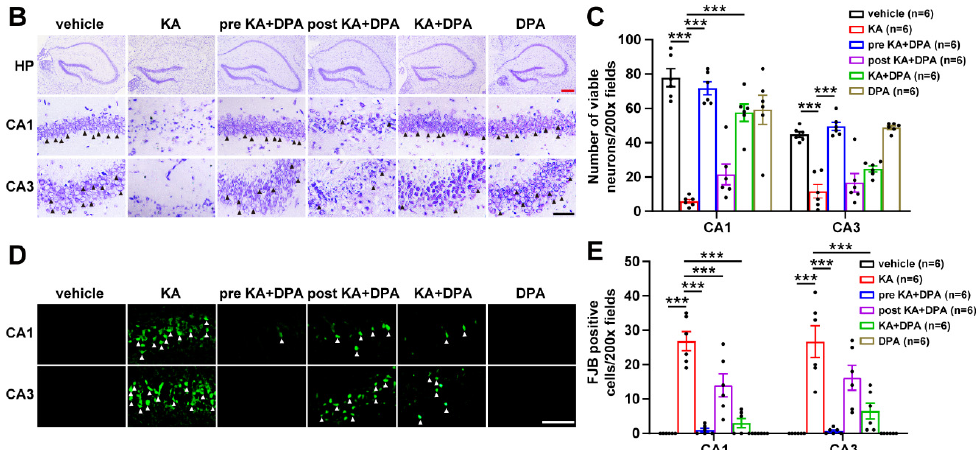
Figure 1. DPA ameliorates seizure-induced neuronal injury in KA-treated mouse model. ( A ) Exper- imental regimen for DPA (0.5 mg/kg) treatment. KA (250 ng/ μ L) was stereotactically injected to induce repetitive seizures (status epilepticus, marked with SE in this figure). Histological analysis including Nissl staining and FJB detection was carried out 3 d after KA or PBS injection. ( B ) Repre- sentative images by Nissl staining in the hippocampus showing the effects of DPA on viable neu- rons in KA-treated mice. Arrows indicate Nissl positive cells. Red scale bar indicates 200 μ m; black scale bar indicates 50 μ m. ( C ) Statistical analysis of Nissl staining results in hippocampal CA1 and CA3 subregions. ( D ) Representative images by FJB staining in the hippocampus showing the effects of DPA on the neurodegeneration in KA-treated mice. Arrows indicate FJB positive cells. Scale bar indicates 25 μ m. ( E ) Statistical analysis of FJB staining results in hippocampal CA1 and CA3 subre- gions. All the data were expressed as mean ± SEM ( n = 6). *** p < 0.001. Abbreviation: DPA, D- penicillamine; KA, kainic acid; SE, status epilepticus; PBS, phosphate buffered saline; FJB, Fluoro- Jade B; HP, hippocampus.